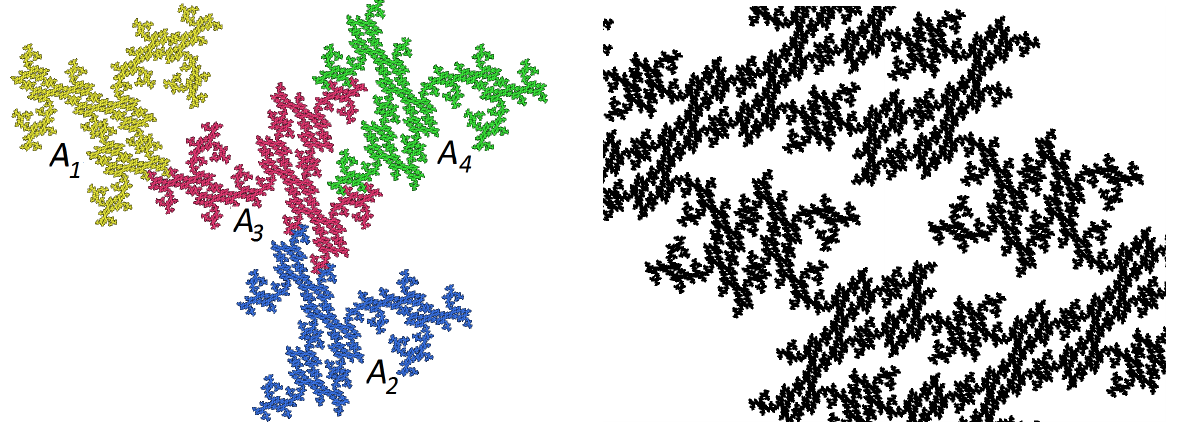
Figure 3. A carpet with a simple structure involving an irrational rotation, and a